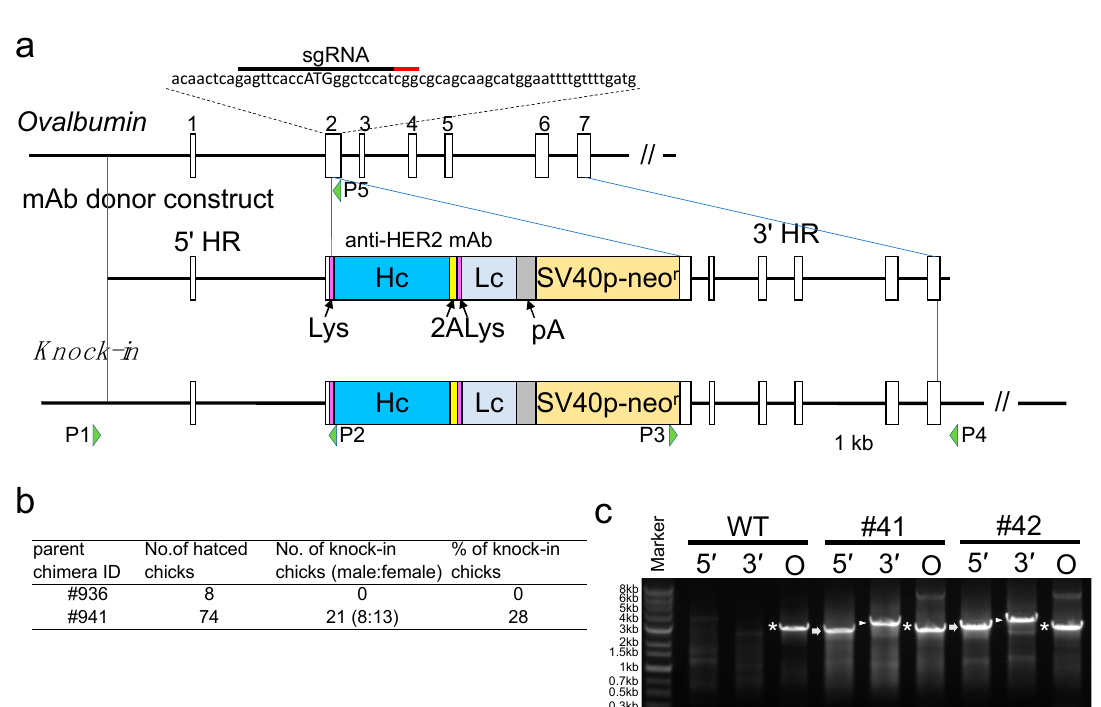
Figure 1. CRISPR/Cas9 ‐ mediated humanized anti ‐ HER2 monoclonal antibody (mAb) gene knock ‐ in at the initiation site of the OVA locus. ( a ) Schematic representation of the knock ‐ in for the OVA locus. The top diagram shows exon–intron organization for the OVA locus. Boxes with numbers indicate OVA exons. The target single ‐ guide RNA (sgRNA) and the protospacer adjacent ‐ motif sequences in exon 2 are indicated by the black and red bars, respectively, above the nucleotide sequence. The initiation codon of OVA is shown in capital letters. The middle diagram shows the mAb donor construct. It consists of a 5 ′ homology region (HR), followed by DNA sequences of the lysozyme signal (Lys), heavy chain of the anti ‐ HER2 mAb (Hc), furin ‐ 2A peptide (2A), another Lys, light chain of the anti ‐ HER2 mAb (Lc), bovine growth hormone polyadenylation signal (pA), neomycin resistance gene driven by the SV40 promoter (SV40p ‐ neo r ), and a 3 ′ HR. The bottom diagram shows the knock ‐ in (KI) allele. P1 to P4 indicate the primers used for 5 ′ and 3 ′ OVA assays. ( b ) Percentage of KI chicks among the offspring of chimeras. ( c ) PCR amplification of the KI allele in the genome of KI chickens. The genomes of mAb KI (#41 and #42) and wildtype (WT) hens were PCR amplified using primers P1–P2, P3–P4, and P1–P5 for 5 ′ , 3 ′ , and endogenous OVA assays, respectively. PCR amplicons, showing the expected sizes of 2.8 kb for the 5 ′ assay (5 ′ ), 3.3 kb for the 3 ′ assay (3 ′ ), and 2.8 kb for the endogenous OVA assay (O), are indicated by the arrows, arrowheads, and asterisks, respectively.